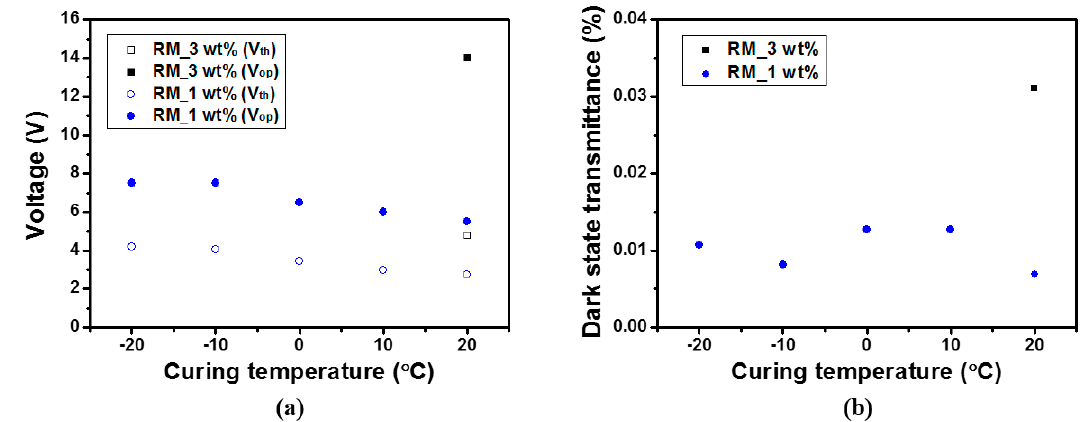
Figure 3. ( a ) Threshold and operating voltages and ( b ) transmittance in the dark state of polymer-stabilized IPS cells with RM concentrations of 1 and 3 wt% as functions of the curing temperature. Table 1. Measured electro-optical characteristics of IPS cells fabricated by curing 3 wt% of RM at 20 ◦ C and 1 wt% of RM at − 20 ◦